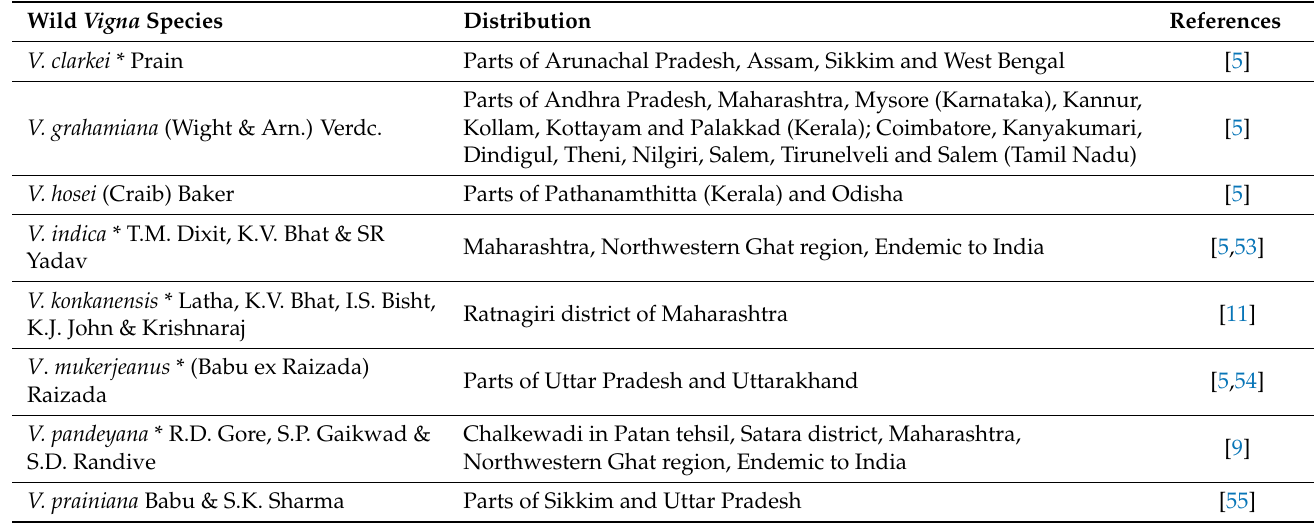
Table 2. Wild Vigna species not represented in the genebank that are priorities for collection. Wild Vigna Species